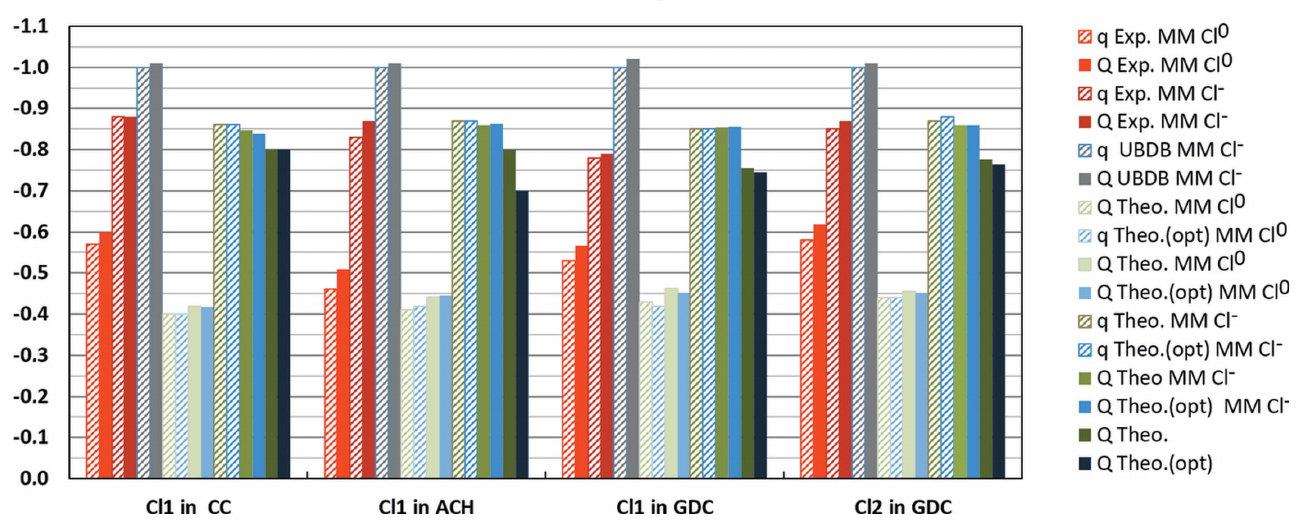
Figure 6 Values of chloride anion charges (e) in studied crystals according to different methods: q – charge computed directly from P val parameters of the multipolar model (MM) obtained from UBDB modelling ( UBDB ) or from refinements against either experimental (Exp.) or theoretical (Theo.) structure factors with the use of ionic (Cl (cid:4) ) or neutral (Cl 0 ) radial scattering functions for chloride; Q – charge computed from integration over atomic basins of crystal electron densities from various multipolar models or directly from periodic quantum mechanical calculations. (opt) – results from periodic calculations with geometry